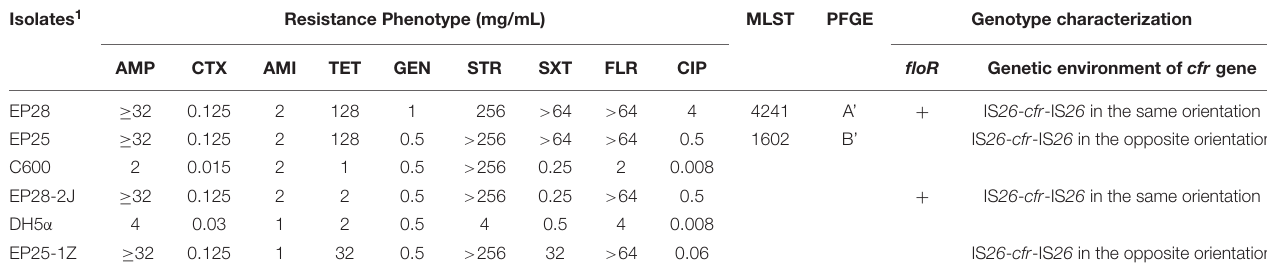
TABLE 3 | Characteristics of 2 cfr -carrying E. coli isolates and their transconjugant/transformant. Isolates 1 Resistance Phenotype (mg/mL) MLST PFGE